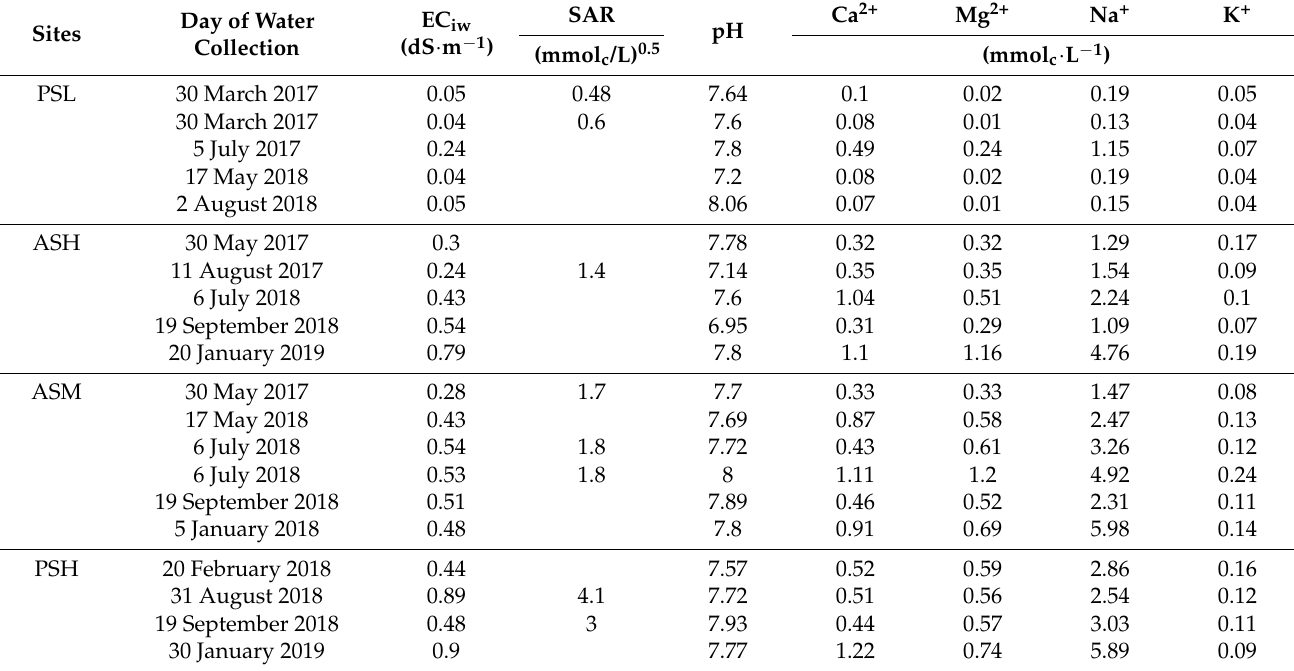
Table 2. Irrigation water salinity, sodicity, and ionic composition at four experimental